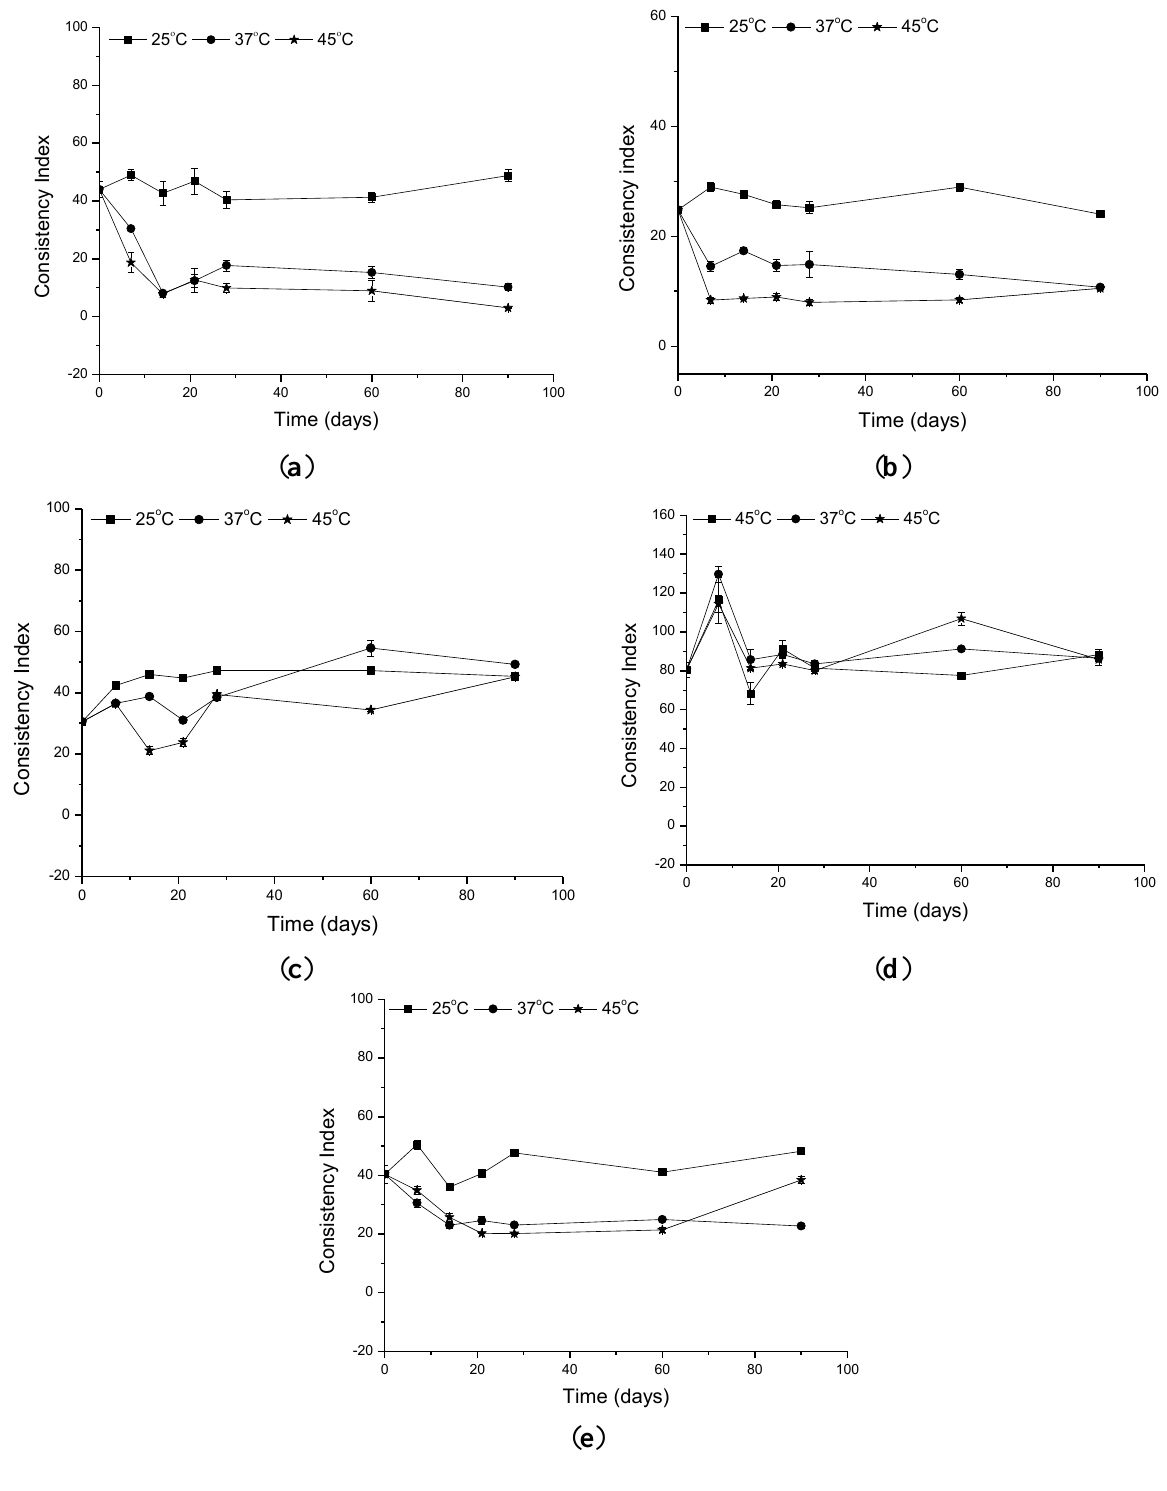
Figure 4. Changes in the consistency index of the ( a ) formulation vehicle ( b ) formulation containing the organic UV filters ( c ) formulation supplemented with CePO supplemented with TiO ; and ( e ) formulation supplemented with ZnO at different storage 2 times and